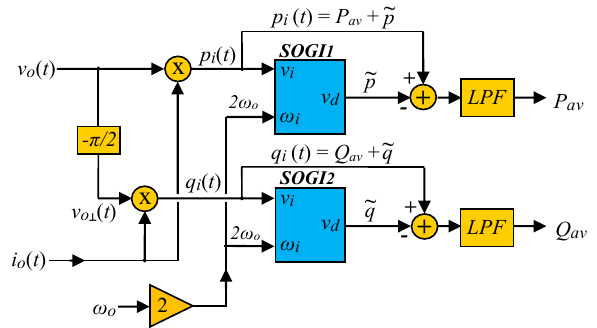
Figure 8. Scheme for the calculation of P av and Q av proposed in [20].